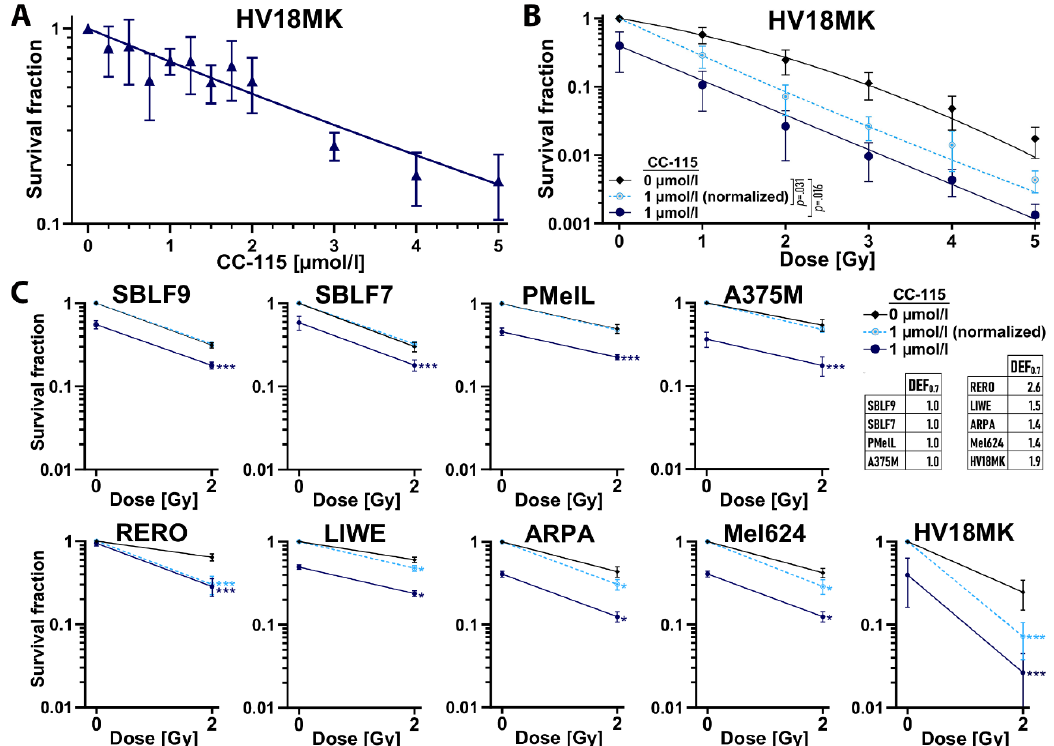
Figure 4. Colony forming assay to study the radiosensitizing potential of CC-115. ( A ) Decreasing survival fractions (SF) in colony forming assay under increasing CC-115 concentrations (0.25–5 µ mol / L) in melanoma cells culture HV18MK. ( B ) Colony forming assay of HV18MK cells treated with up to 5 Gy IR with / without 1 µ mol / L CC-115. Each value represents mean ± SD ( n = 4). Solid lines (black, blue) represent mean SF. Dashed line (turquoise) represents mean SF normalized to the cytotoxicity induced by CC-115 alone. Significance was determined by one-tailed Mann-Whitney U test; p = 0.031 comparing control to normalized CC-115 treatment; p = 0.016 comparing control to CC-115 treatment. ( C ) Colony forming assay of healthy-donor skin fibroblasts (SBLF9, SBLF7) and melanoma cells (PMelL, A375M, RERO, LIWE, ARPA, Mel624, HV18MK) treated with / without 2 Gy IR with / without 1 µ mol / L CC-115. Solid lines (black, blue) represent mean SF. Dashed line (turquoise) represents mean SF normalized to the cytotoxicity induced by CC-115 alone. Significance was determined by two-tailed Mann–Whitney U test comparing control to normalized CC-115 treatment (turquoise asterisks) or control to CC-115 treatment (blue asterisks), * p ≤ 0.05, *** p ≤ 0.001 ( n = 4). Mean dose enhancement factors (DEF0.7) are shown and were calculated as ratio of the estimated radiation dose at survival of 70% of untreated cells to the normalized CC-115-treated